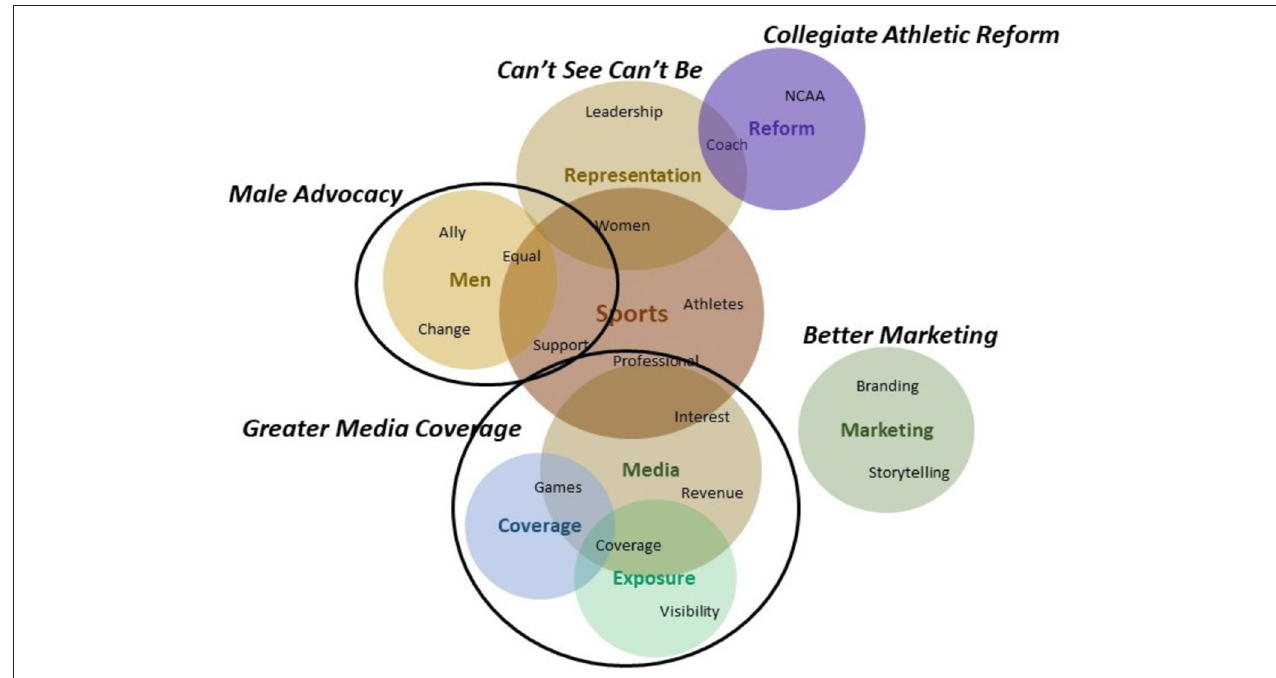
FIGURE 3 | Thematic representation of the frames for question